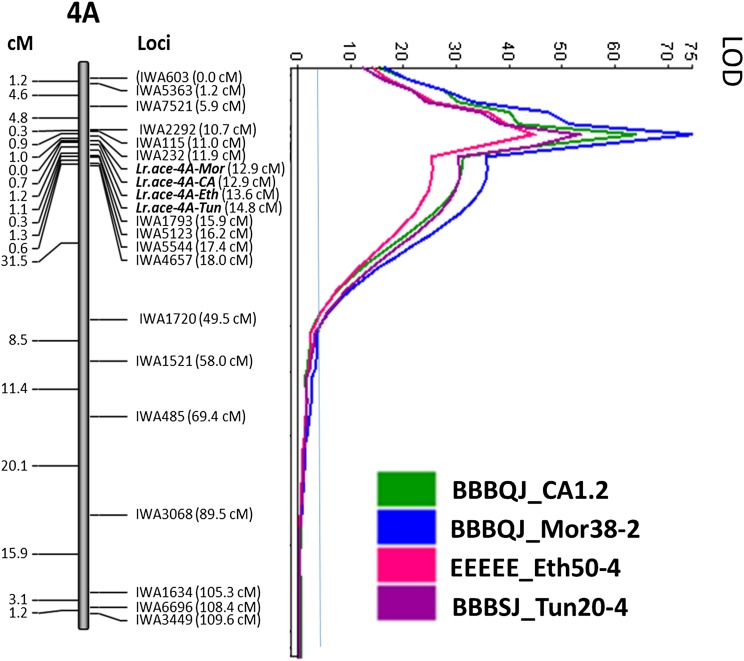
Mapping of leaf rust resistance gene Lr.ace-4A in PI 192051-1 to P. triticina isolates BBBQJ_CA, BBBQJ_Mor, BBBSJ_Tun, and EEEEE_Eth at seedling stage. QTL analysis was performed using composite interval mapping. The QTL analysis LOD threshold is indicated with the blue line. Co-segregating markers were excluded from this map. SNPs and their cosegregating markers are presented in Figure S2.